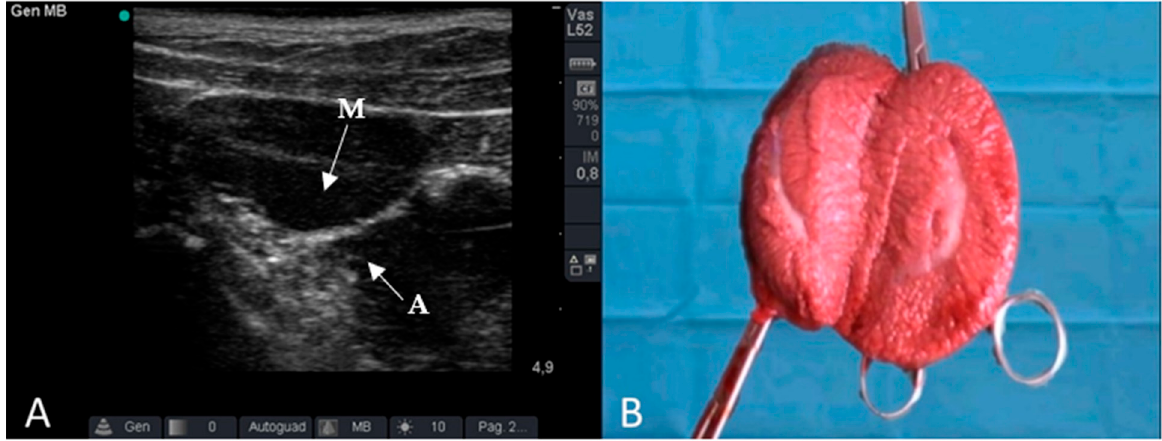
Figure 2. Ultrasound ( A ) and macroscopic features ( B ) of the undescended testicle. (A) tunica al- buginea, (M): mediastinum. albuginea, (M): mediastinum.